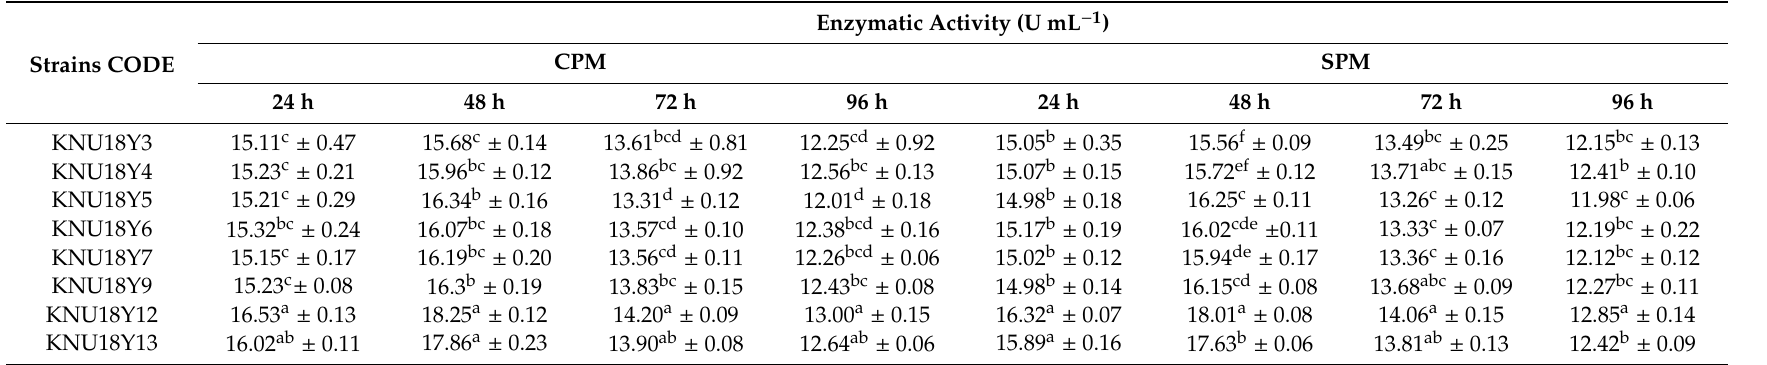
Table 9. Pectin methylesterase (PME) activity of the yeasts after fermentation in CPM and SPM (24, 48, 72, and 96 h).